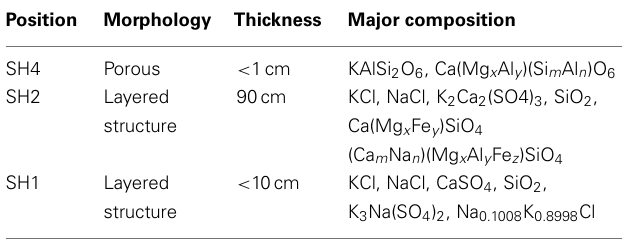
Table 1 | Slag composition in superheater.